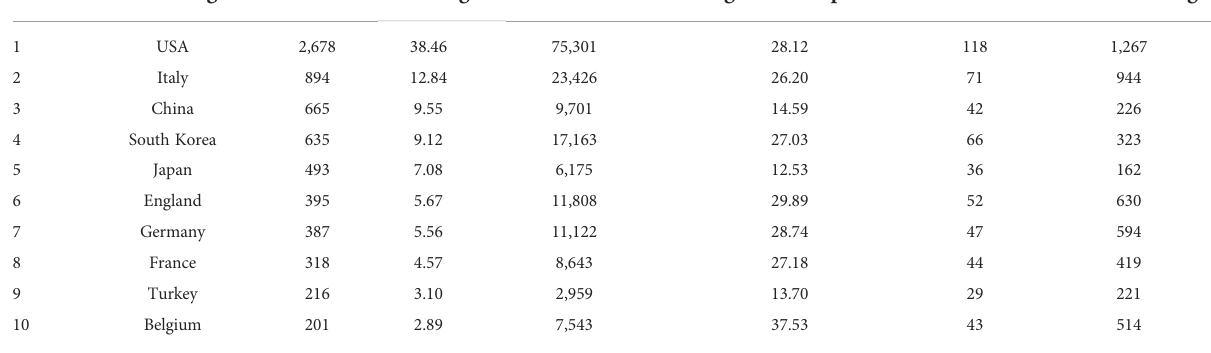
TABLE 1 The top 10 countries/regions in the number of publications related to robotic surgery in oncology. Rank